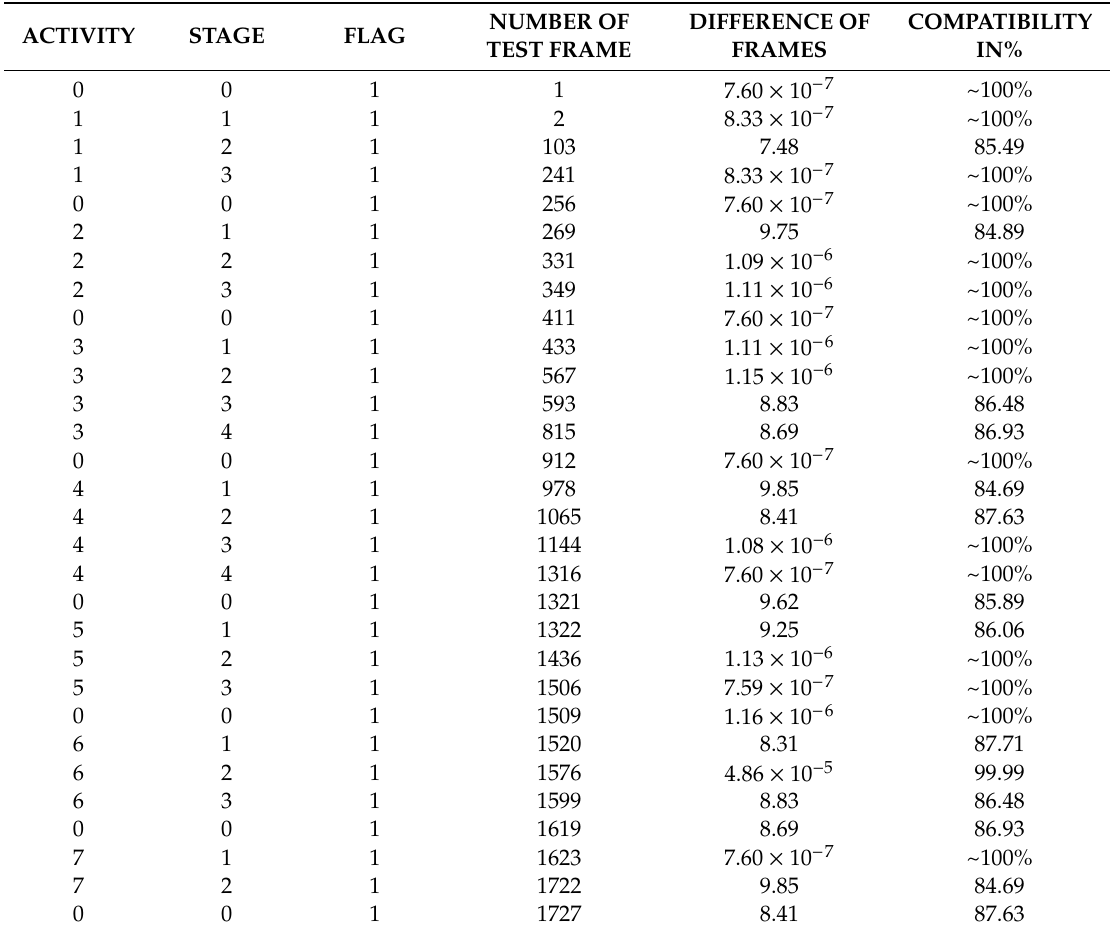
Table 4. Result of the evaluation of the